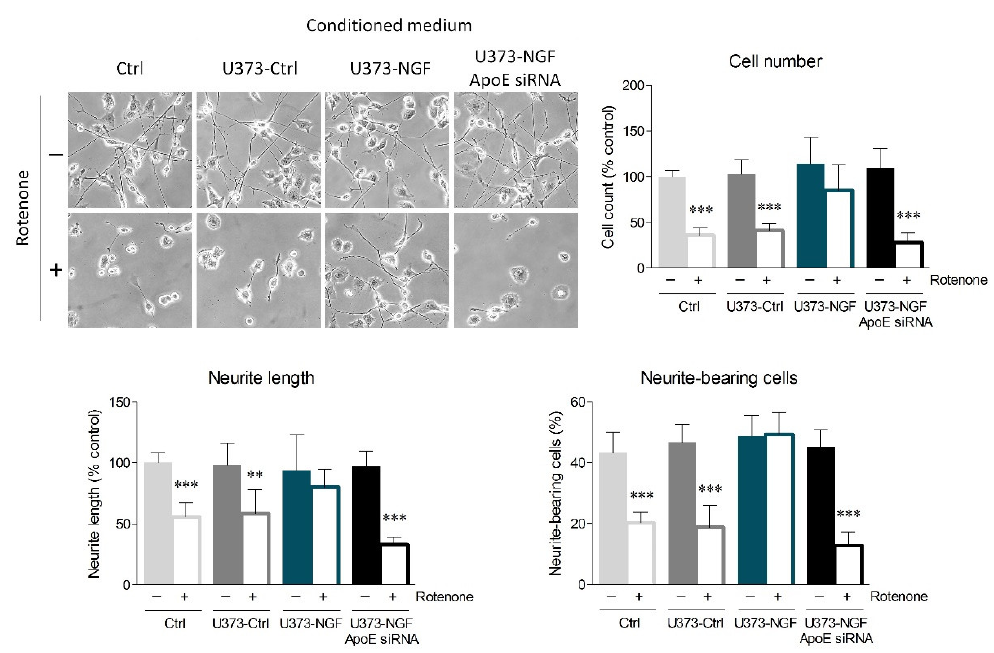
Figure 5. Effects of U373 conditioned medium on oxidative stress in neurons. Representative images in bright field and quantitative assessment of neuronal morphology of N1E-115. Cells were previously treated (+) or not (−) with rotenone (0.1 µM) for 16 h, and then cultured in fresh DMEM (Ctrl), in conditioned medium derived from control U373 (U373-Ctrl), NGF-pre-treated U373 (U373-NGF), and NGF-pre-treated U373 silenced for apoE (U373-NGF ApoE siRNA) for 48 h. n = 5 different experiments. Data represent means ± SD. Statistical analysis was assessed by using one-way ANOVA, followed by Tukey’s post hoc test. ** p < 0.01, *** p < 0.001. To strengthen the results obtained from conditioned medium, we performed U373/N1E- 115 co-cultures. To start, U373 cells were pre-treated or not with NGF for 48 h. Furthermore, differentiated N1E-115 cells were pre-treated or not with rotenone for 16 h. Subsequently, U373 medium was replaced with fresh medium containing 0.5% FBS, and coverslips seeded with N1E-115 were transferred onto the U373 layer to prepare co-cultures (Figure 6A). Ox- idative damage elicited by rotenone treatment considerably affected cell viability, neurite- bearing cells, and neurite length of control N1E-115 and N1E-115 co-cultured with U373-Ctrl astrocytes (Figure 6B). Consistent with conditioned medium experiments, N1E-115 cells co-cultured with U373-NGF cells were protected from oxidative damage, whereas ApoE silencing in U373 abolished the neuroprotection sustained by